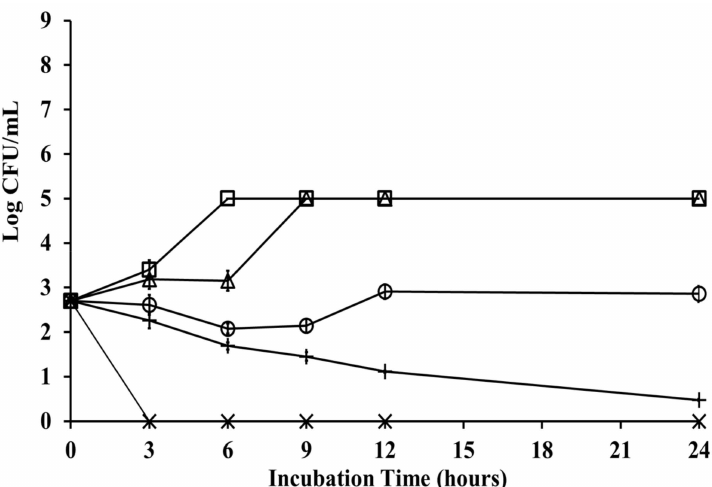
Figure 3. The time-kill e ff ect of chlorogenic acid against Porphyromonas gingivalis . The cumulative change in the growth of the P. gingivalis strain after treatment with di ff erent concentrations of chlorogenic acid. The results show the antibacterial e ff ect of chlorogenic acid at concentrations of ( (cid:52) ) 2 mg / mL, ( 4 mg / mL, ( + ) 8 mg / mL, ( × ) 16 mg / mL, and ( (cid:3) ) 10% dimethyl sulfoxide of the negative control group, respectively. Chlorogenic acid at the MBC concentration showed a bactericidal e ff ect after 3 h